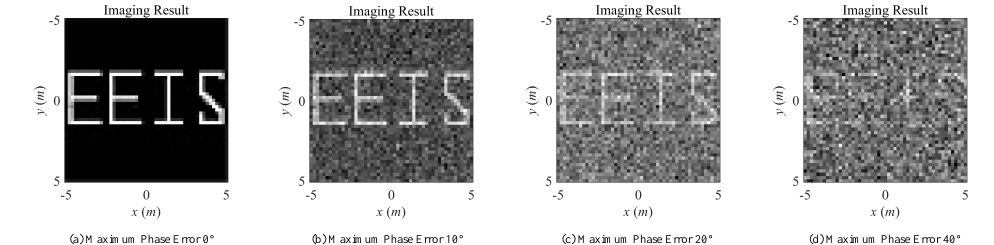
Figure 8. Imaging results with different levels of phase errors.